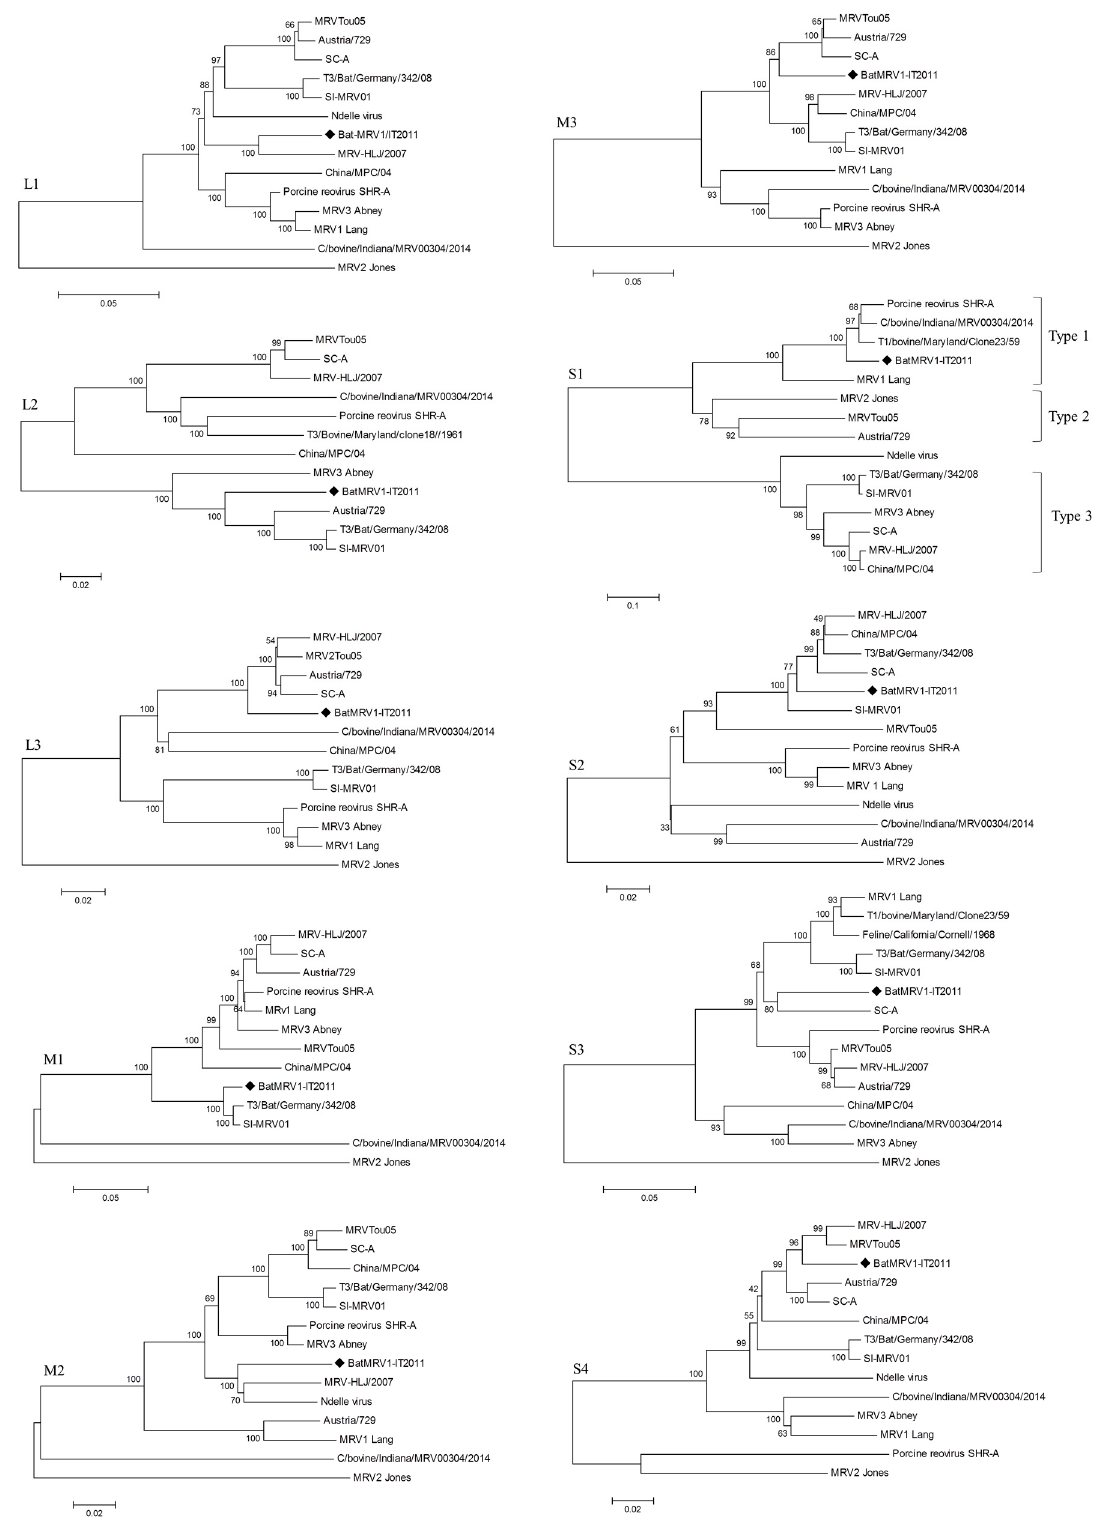
Figure 2. Phylogenetic trees of the BatMRV1-IT2011 strain’s genome segments ( (cid:7) ) and the closest related whole-genome MRV strains from GenBank.